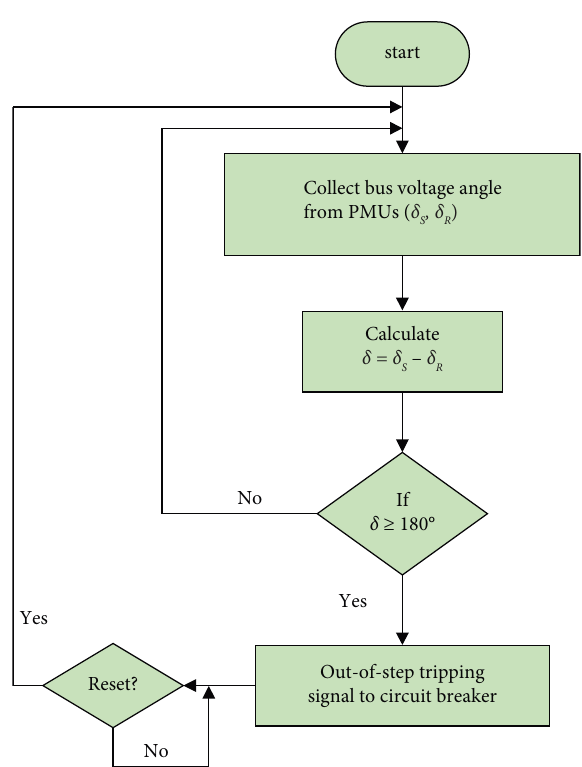
Figure 6: Proposed algorithm based on voltage angle